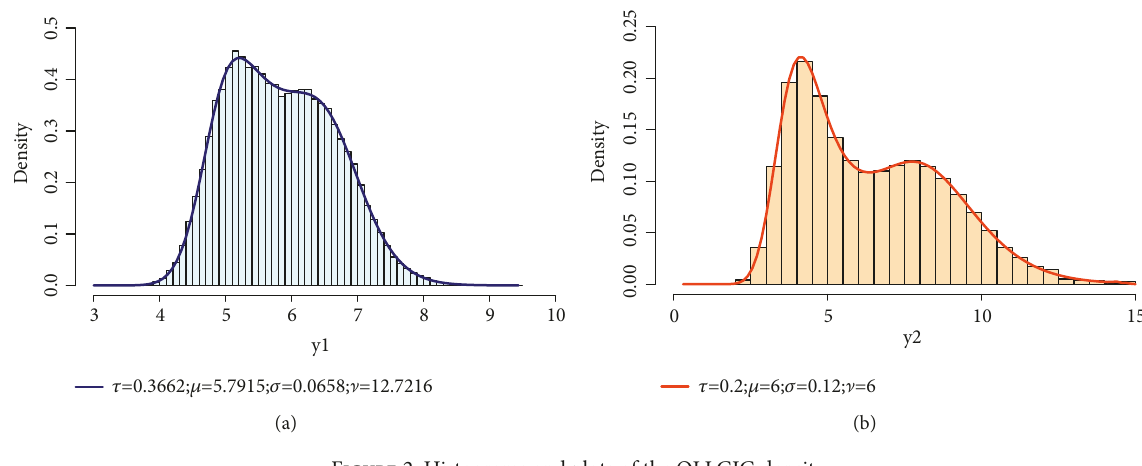
Figure 1: Plots of the OLLGIG density for some parameter values.